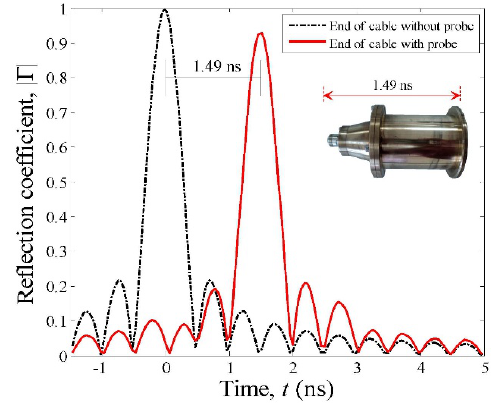
Figure 3. Variation in phase shift φ AA ′ with air thickness, h backed by metal plate at ( a ) 50 MHz and ( b ) 400 MHz.